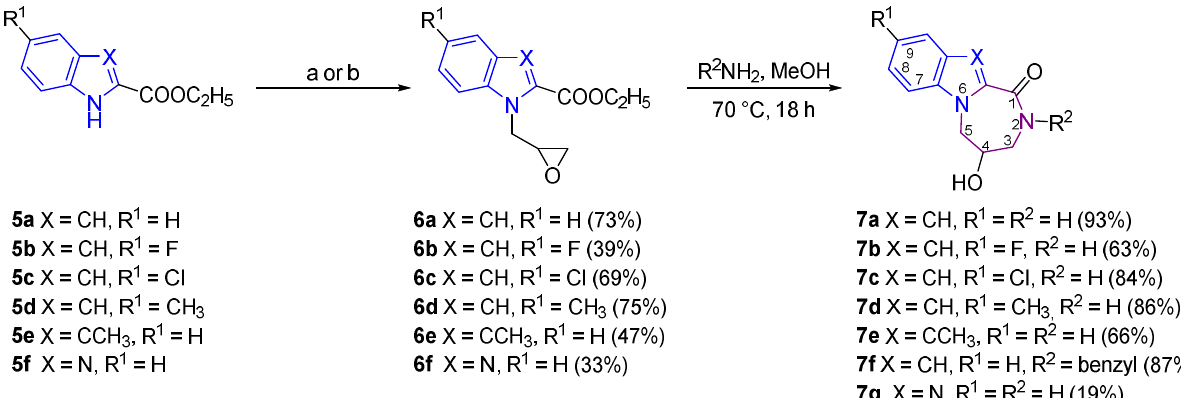
Table 2. Optimization of reaction conditions between 5a and 2-(chloromethyl)oxirane.